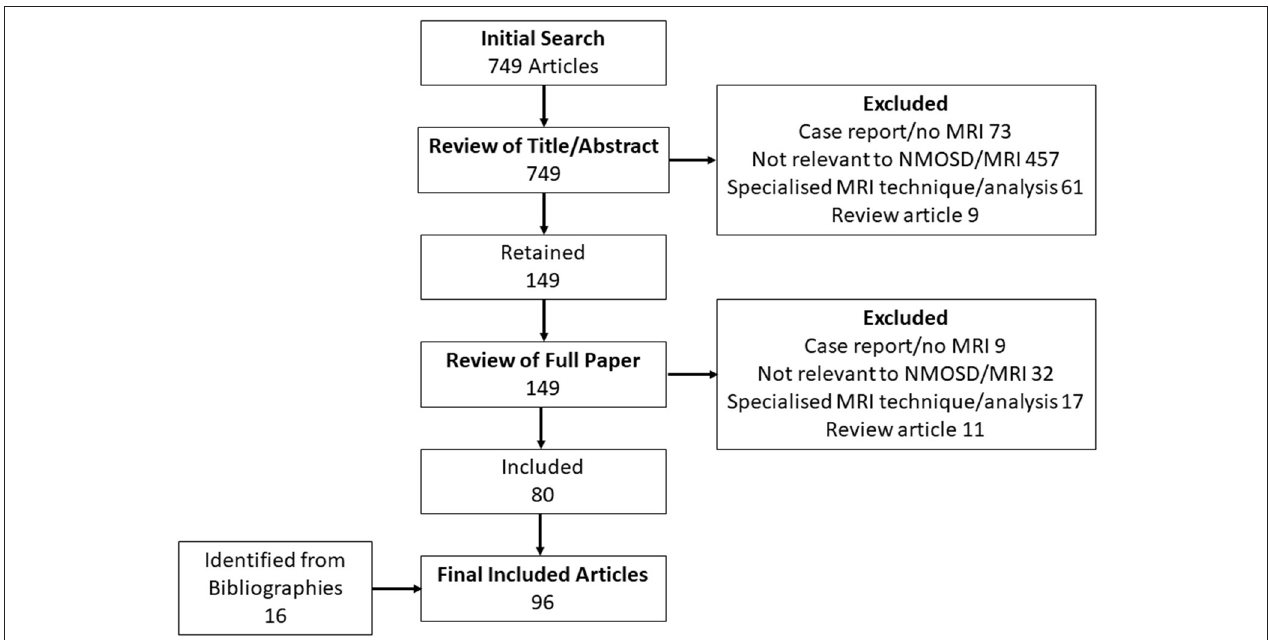
FIGURE 2 | Flow chart of results of literature search used to identify MRI lesions and features associated with NMOSD and MS.